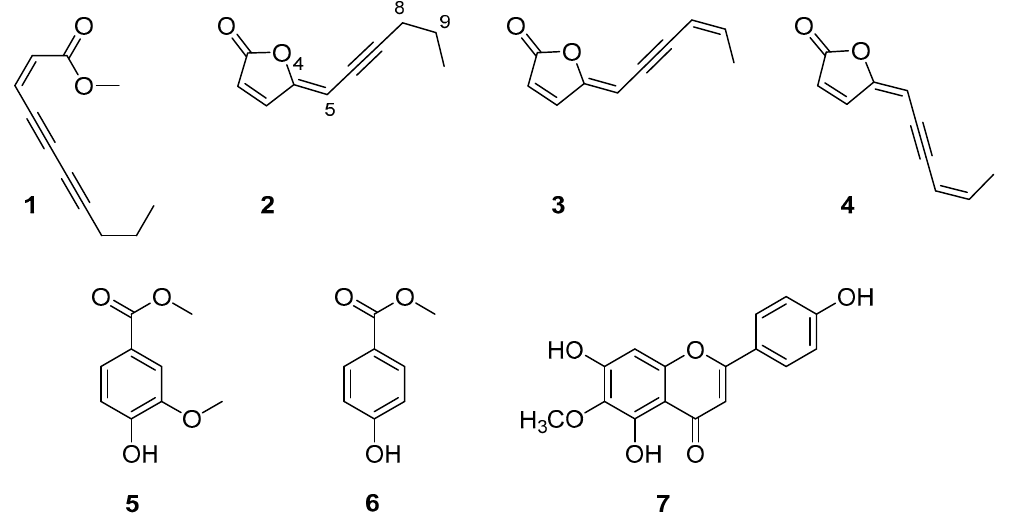
Figure 2. Compounds isolated from Conyza bonariensis shoot extracts.